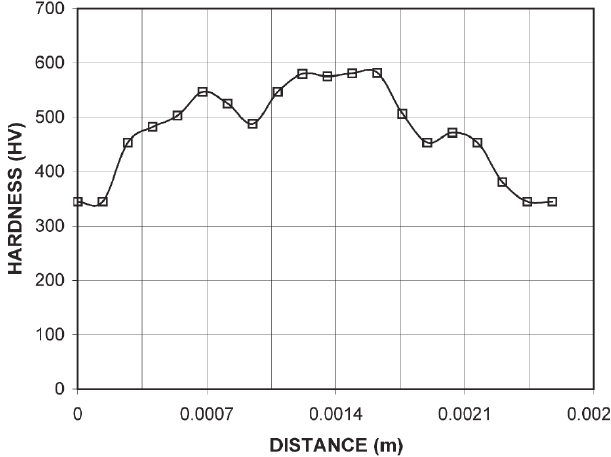
Table 5. Comparison of microhardness (HV) values from Figures 14 and 15. HV for one shock HV for two shocks Figure (Reference) Minimum